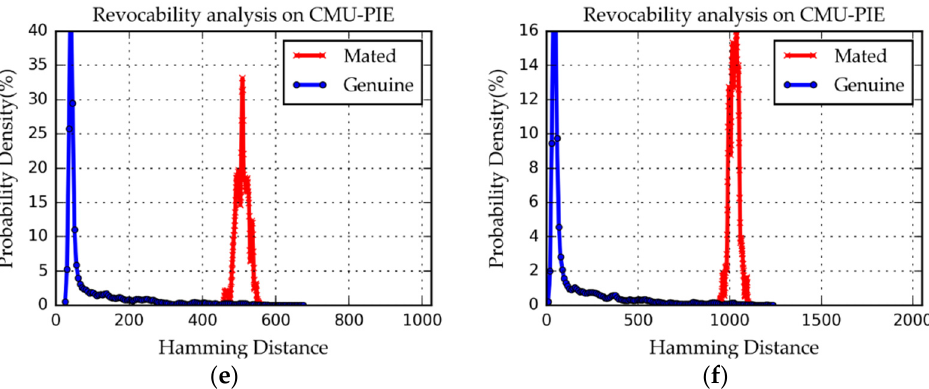
Figure 7. The distributions of Hamming Distance between the new bio-keys and the old bio-keys for intra-user, applied on ( a ) ORL at 𝑙 = 1024 ; ( b ) ORL at 𝑙 = 2048 ; ( c ) Extended YaleB at 𝑙 = 1024 ; ( d ) Extended YaleB at 𝑙 = 2048 ; ( e ) CMU-PIE at 𝑙 = 1024 ; ( f ) CMU-PIE at 𝑙 = 2048 .